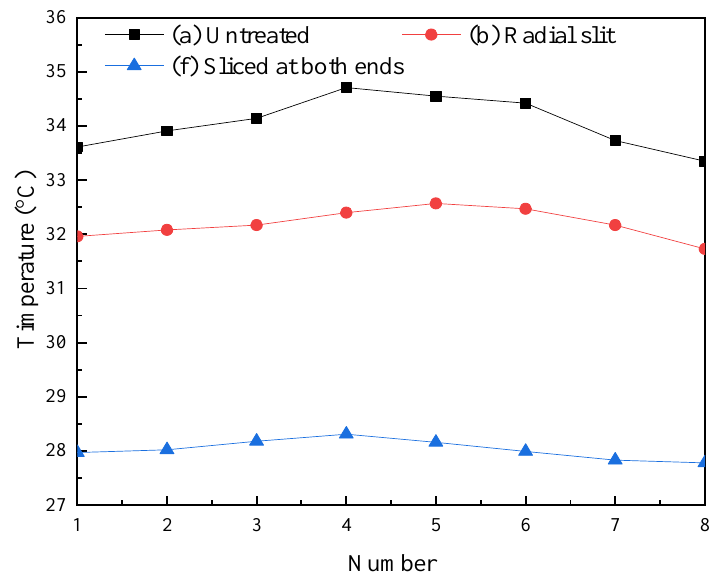
Figure 8. Axial temperature of Terfenol-D rods. Table 2. Temperatures of Terfenol-D rods after working for 30 min.